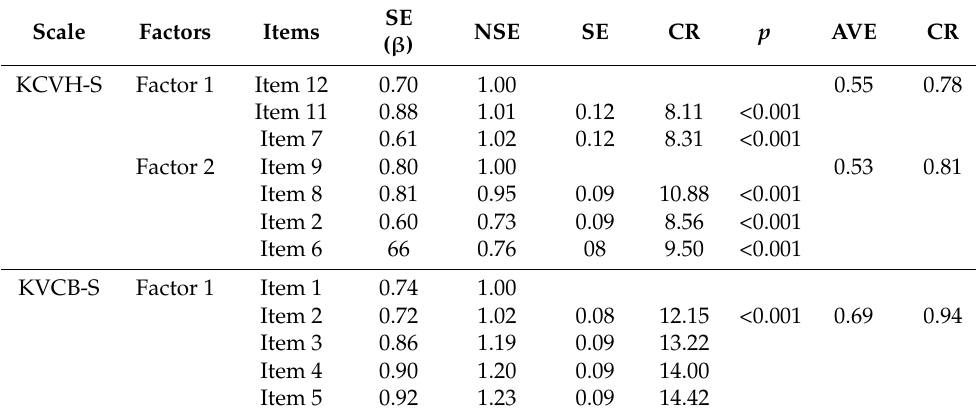
Table 4. Analysis of convergent validity of